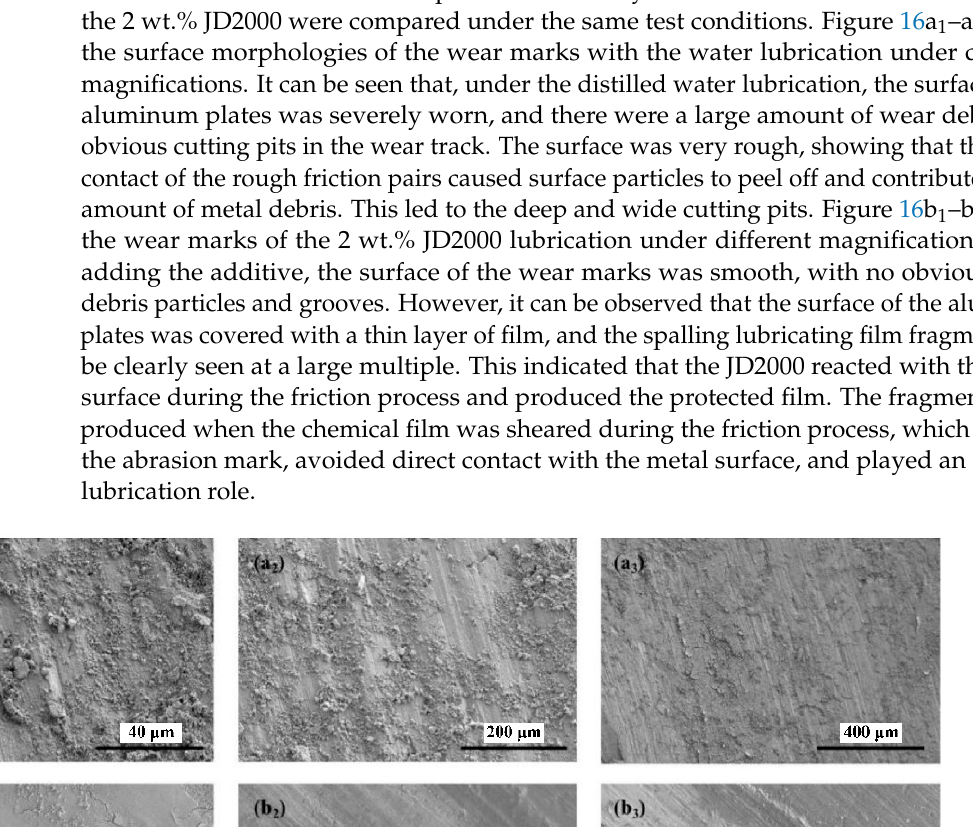
Figure 17. The MS spectra of the friction-tested aluminum plates lubricated using the 2% JD2000 aqueous solution. The wear marks obtained by lubrication with the distilled water and 2 wt.% JD2000 under the same test conditions of the aluminum plates were analyzed using EDS, and the different element contents of the friction film were obtained. The results are shown in Table 2. When the distilled water was used as the lubricating fluid, the content of Al in the wear mark was as great as 74.2%, which is the primary component of the wear mark surface. In addition, it also contained a small amount of O and Mg, which came from the water and friction material, respectively. When the JD2000 was added into the water, the primary elements of the abrasion mark were Al, O, and C, and a portion of the C and O elements came from the JD2000. In addition, the primary composition of the friction film